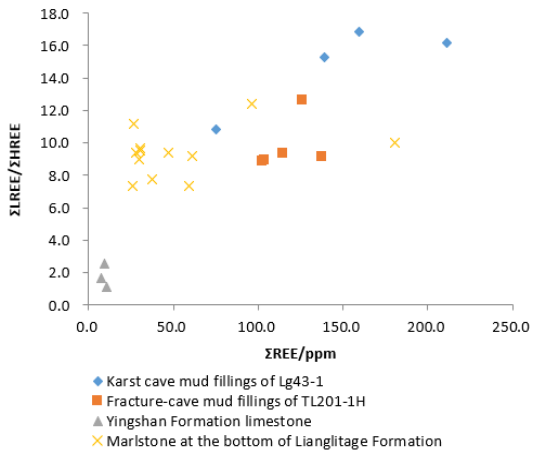
Figure 8. Correlation between the total amount of rare earth and the ratio of light to heavy rare earth of the fracture ‐ cave fillings in the northern slope of Tazhong.